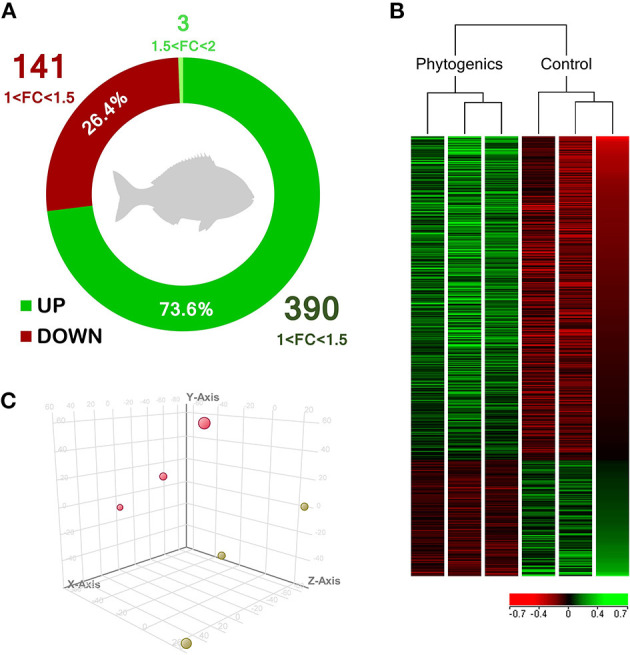
Skin transcriptomic profile of gilthead seabream (Sparus aurata) fed a diet supplemented with a blend of garlic essential oil, carvacrol and thymol. (A) Differential expression analysis of the gilthead seabream skin transcriptomic response fed a diet supplemented with a blend of garlic, carvacrol and thymol. (B) Hierarchical clustering for the control and phytogenic-supplemented diets, based in similitude patterns of the differentially expressed genes (DEGs) detected from three sample pools per dietary group. Data of the six microarrays are depicted, one for each represented pool. Both increased and decreased gene expression pattern is shown in green and red, respectively. All transcripts represented are statistically significant (P < 0.05). (C) Principal component analysis (PCA) of the DEGs of gilthead seabream skin response to the control diet (yellow) and phytogenic-supplemented diet (pink). Please refers to Supplementary Table 1 for details.